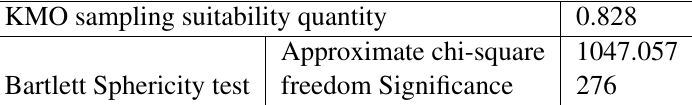
Table 8 KMO and Bartlett’s test for the pretest